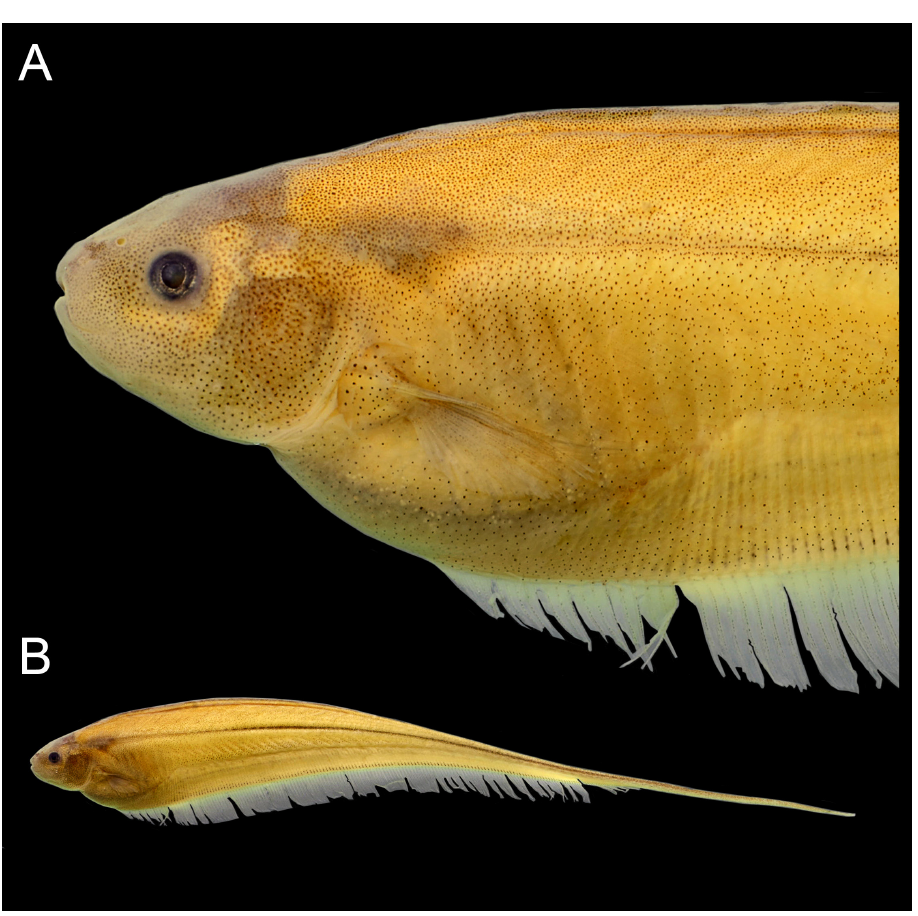
FIGURE 5 | Eigenmannia cacuria , MZUSP 125871, holotype, 110.0 mm LEA, riacho Enxada, Alto